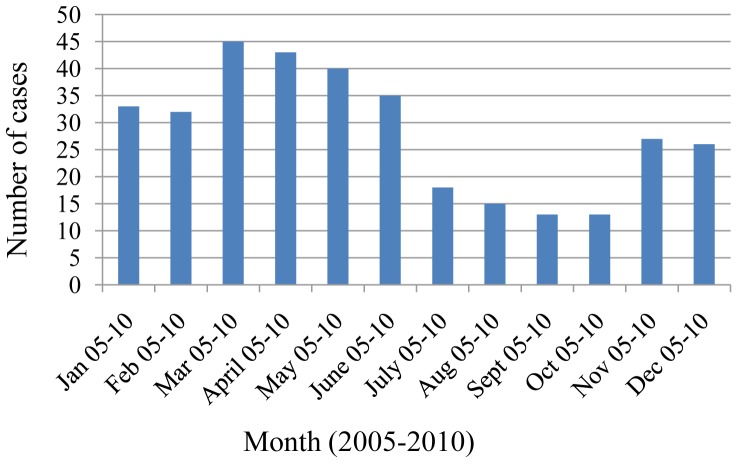
HAdV cases per month from 2005–2010.The actual number of cases each month and for each year is displayed along the y-axis.